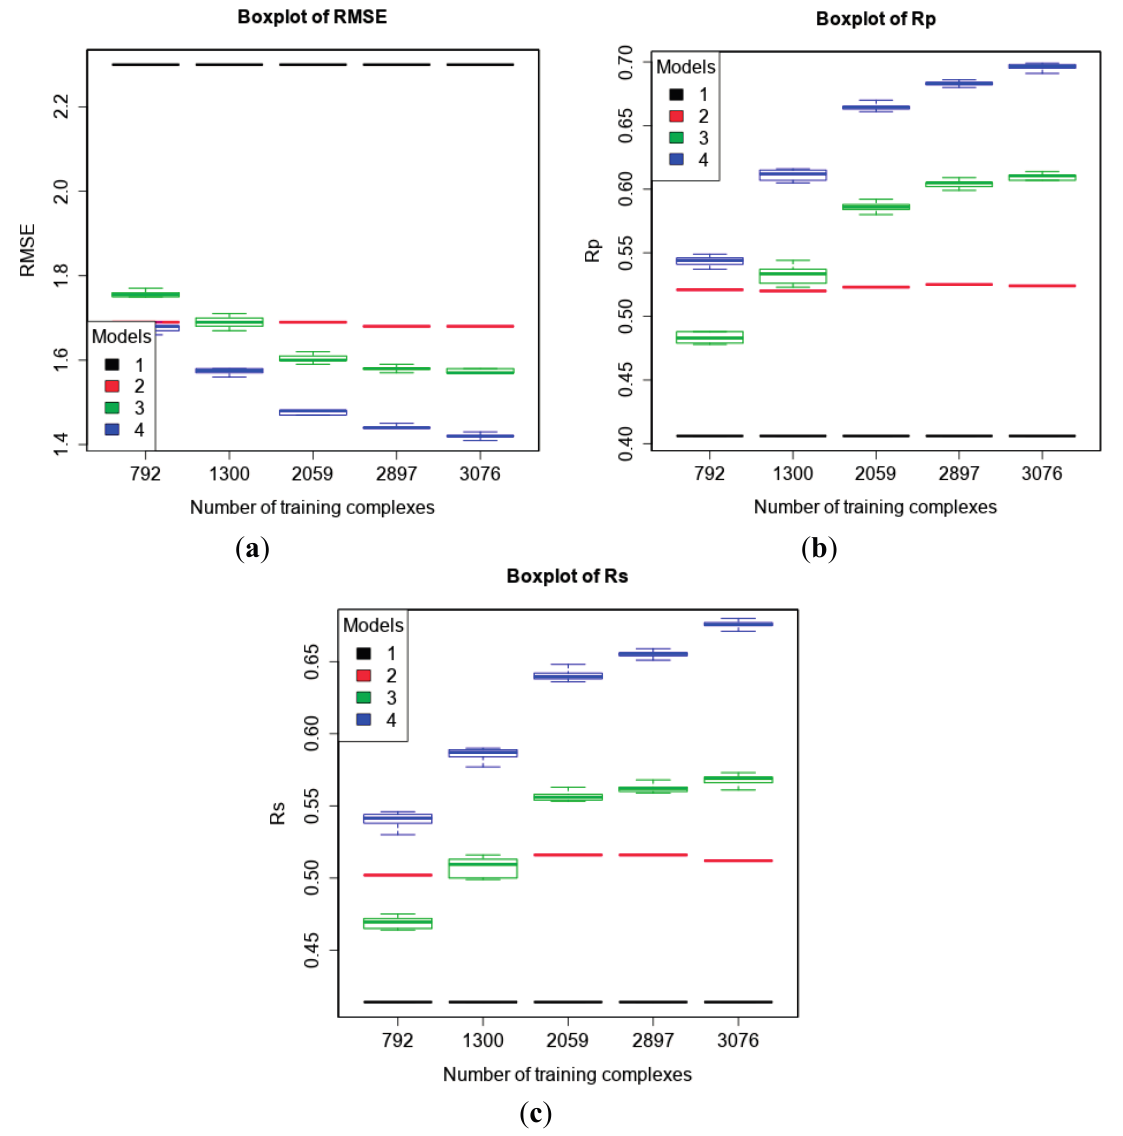
Figure 1. Performance of the four models with five training sets of incremental size on the test set of PDBbind v2013 refined set minus v2012 refined set ( n = 382) according to RMSE ( a ); R p ( b ) and R s ( c ). Models: 1 (Vina), 2 (MLR::Vina), 3 (RF::Vina) and 4